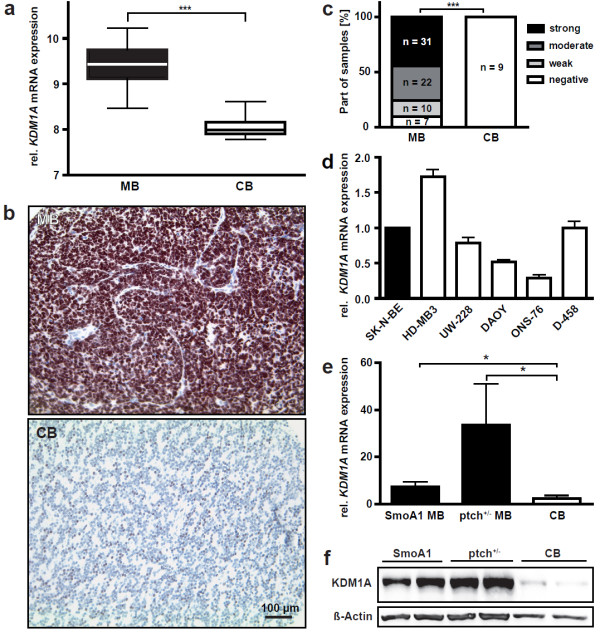
KDM1A is strongly overexpressed in human medulloblastomas, cell lines derived from them and murine medulloblastic tumors. a Data from a representative cohort of 62 medulloblastomas (MB) and normal cerebellar tissue (CB) used in a published microarray analysis [22,23] were re-analyzed for KDM1A expression. ***p < 0.0001 b KDM1A protein expresion was evaluated immunohistochemically in a tissue microarray of 70 medulloblastomas (MB) and 9 tissue samples of normal cerebellum (CB). Micrograph showing KDM1A-positive staining in a representative MB sample, and KDM1A-negative staining in CB, scale bar = 100 μm. c Bars reflect the proportion of cells with strong (black), moderate (dark grey), weak (light grey) or no (white) nuclear KDM1A staining. A two-tailed student’s t-test revealed a significant upregulation of KDM1A protein in the medulloblastomas represented in the tissue microarrays. ***p < 0.0001 d Bars represent KDM1A expression measured using real-time RT-PCR and normalized to the geometric mean of GAPDH, UBC and HPRT expression in a panel of human medulloblastoma cell lines derived from diverse histological tumor subtypes and the SK-N-BE human neuroblastoma cell line, known to express high levels of KDM1A as a reference. e Bars represent KDM1A expression measured using real-time RT-PCR in medulloblastic tumors (black) spontaneously arising in genetically engineered mice with activating mutations in the sonic hedgehog pathway, SmoA1 MB (p = 0.014) and Ptch+/− MB (p = 0.037), compared to normal murine cerebellum (CB, white). f Strong KDM1A protein expression was confirmed in the medulloblastic tumors from SmoA1- and Ptch+/−-mice relative to KDM1A expression in cerebellar tissue (CB) using western blotting of tissue lysates. β-actin expression was used as a loading control.